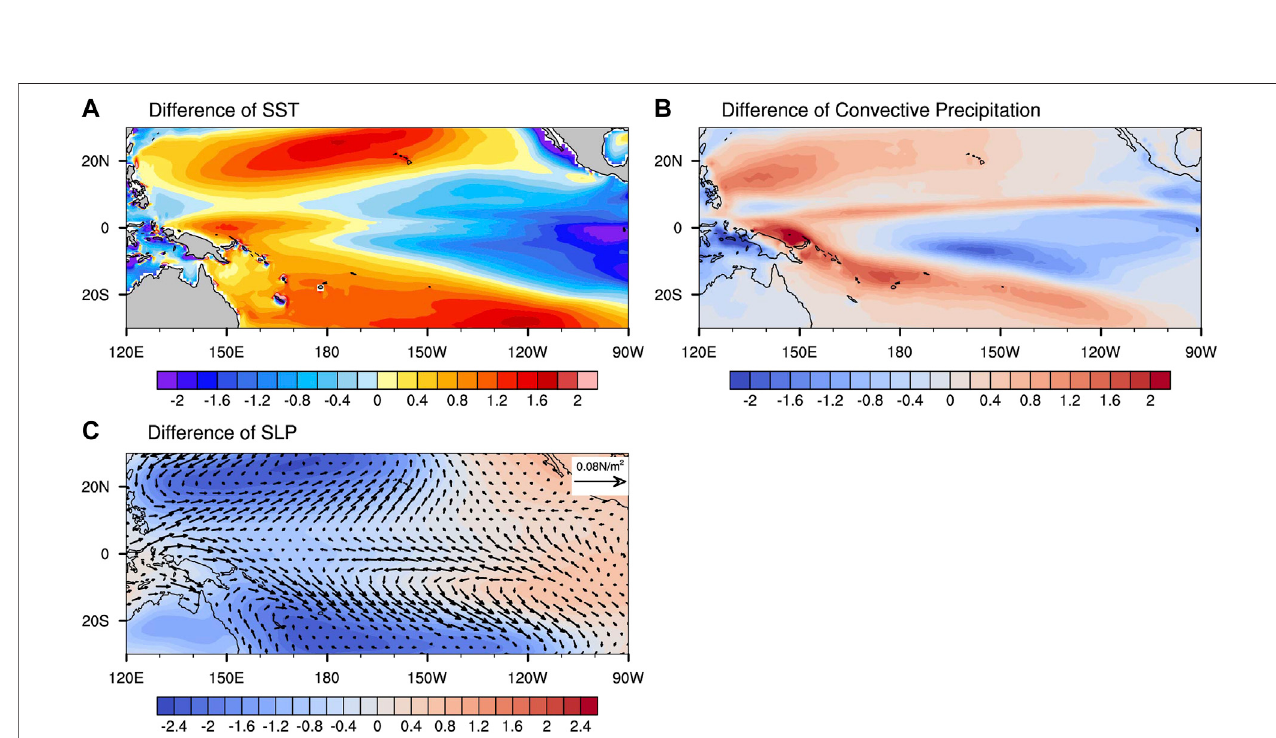
FIGURE 8 | (A) The difference in annual mean SST ( ° C) between SST-Assim experiment and SST-noAssim experiment (SST-Assim minus SST-noAssim); (B) the difference in annual mean convective precipitation (mm/d) between SST-Assim experiment and SST-noAssim experiment (SST-Assim minus SST-noAssim); (C) the differenceinannualmeanseasurfacepressure(shaded,inhPa)andwindstressvector(arrows,inN/m 2 )betweenSST-AssimexperimentandSST-noAssimexperiment (SST-Assim minus SST-noAssim); the average period of the model data is from 1982 to 2014.